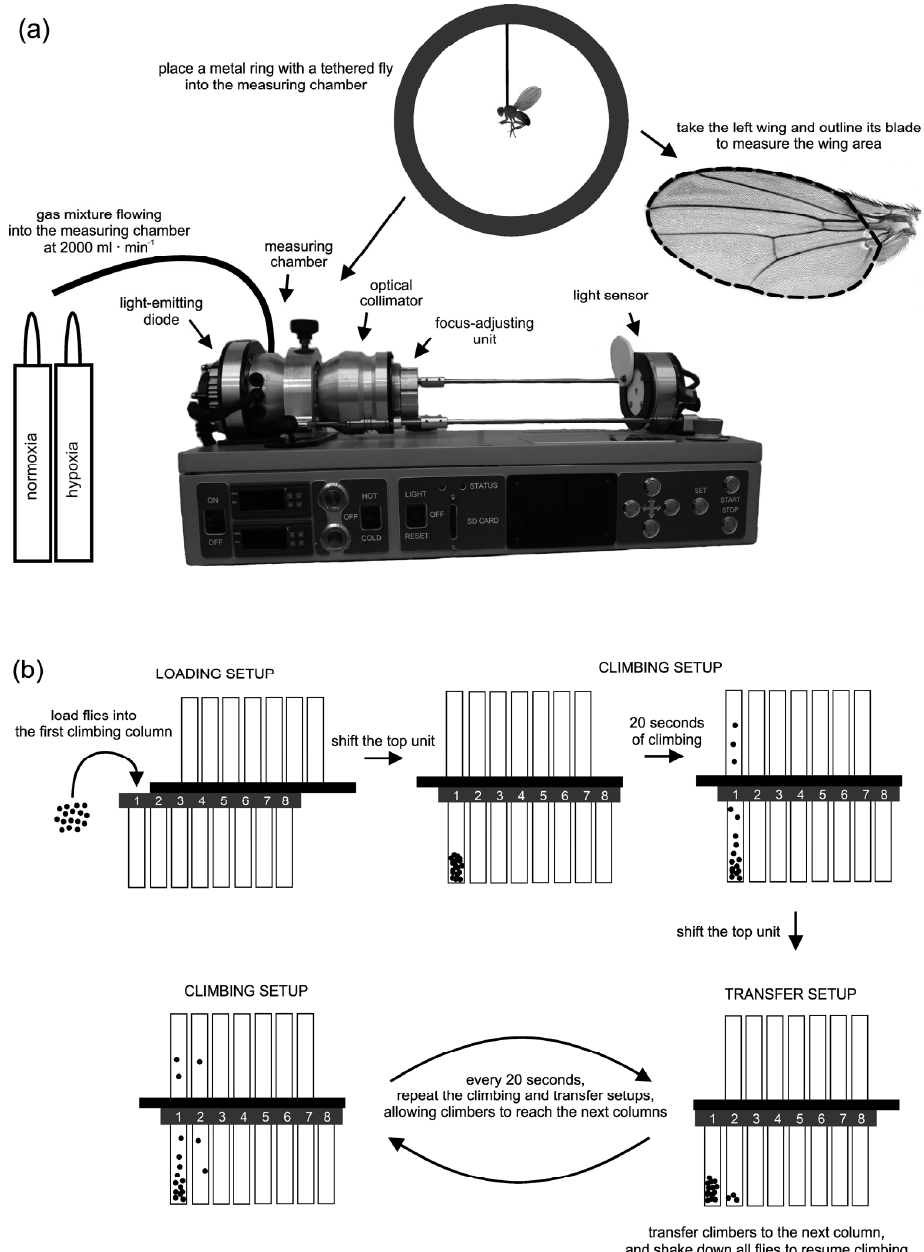
Figure 1. Two types of performance were measured in ageing Drosophila melanogaster . Flight performance was measured with an optical frequency counter ( a ). A tethered fly was mounted in an aluminium ring, which was placed in the measuring chamber. The light beam emitted by a diode travelled through the chamber, focused by an optical collimator on the sensor. The chamber was supplied with a constant flow of either a normoxic or hypoxic gas mixture. The temperature of the inflowing gas was recorded by a thermocouple placed next to the tethered fly. After the measurement, the left wing of the fly was outlined (indicated by a dotted line visible in the wing image placed in the figure) to measure the wing blade area and calculate the wing load. Climbing performance was measured on an apparatus ( b ) with 8 climbing columns as the proportion of flies loaded onto the first column that managed to leave this column by climbing onto the next columns during a series of column shifting cycles (which provided flies with a 140-s time interval that could be utilized to climb up the columns). Every 20 s, the top unit of the apparatus was shifted sideways to transfer climbers to the next columns (transfer setup). Then, the apparatus was shaken to force the climbers down, and the top unit was shifted back to the initial position to allow the flies to resume climbing (climbing setup).